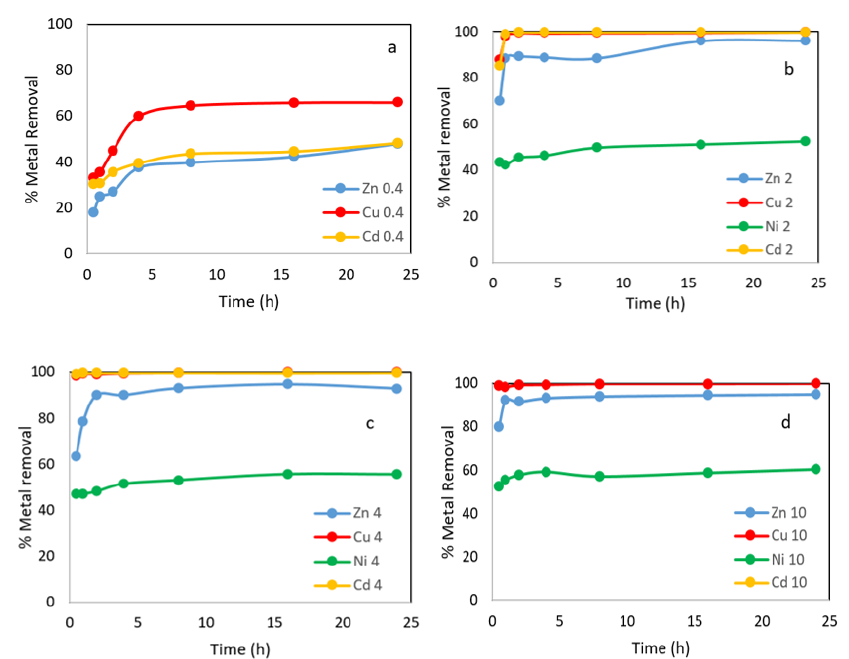
Figure 5. Metals removal onto WS versus time at different adsorbent concentration: 0.4 g L − 1 , 2 g L − 1 , 4 g L − 1 and 10 g L − 1 . ( a ) % metal removal at 0.4 g L − 1 ; ( b ) % metal removal at 2g L − 1 ; ( c ) % metal removal at 4g L − 1 ; ( d ) % metal removal at 10 g L − 1